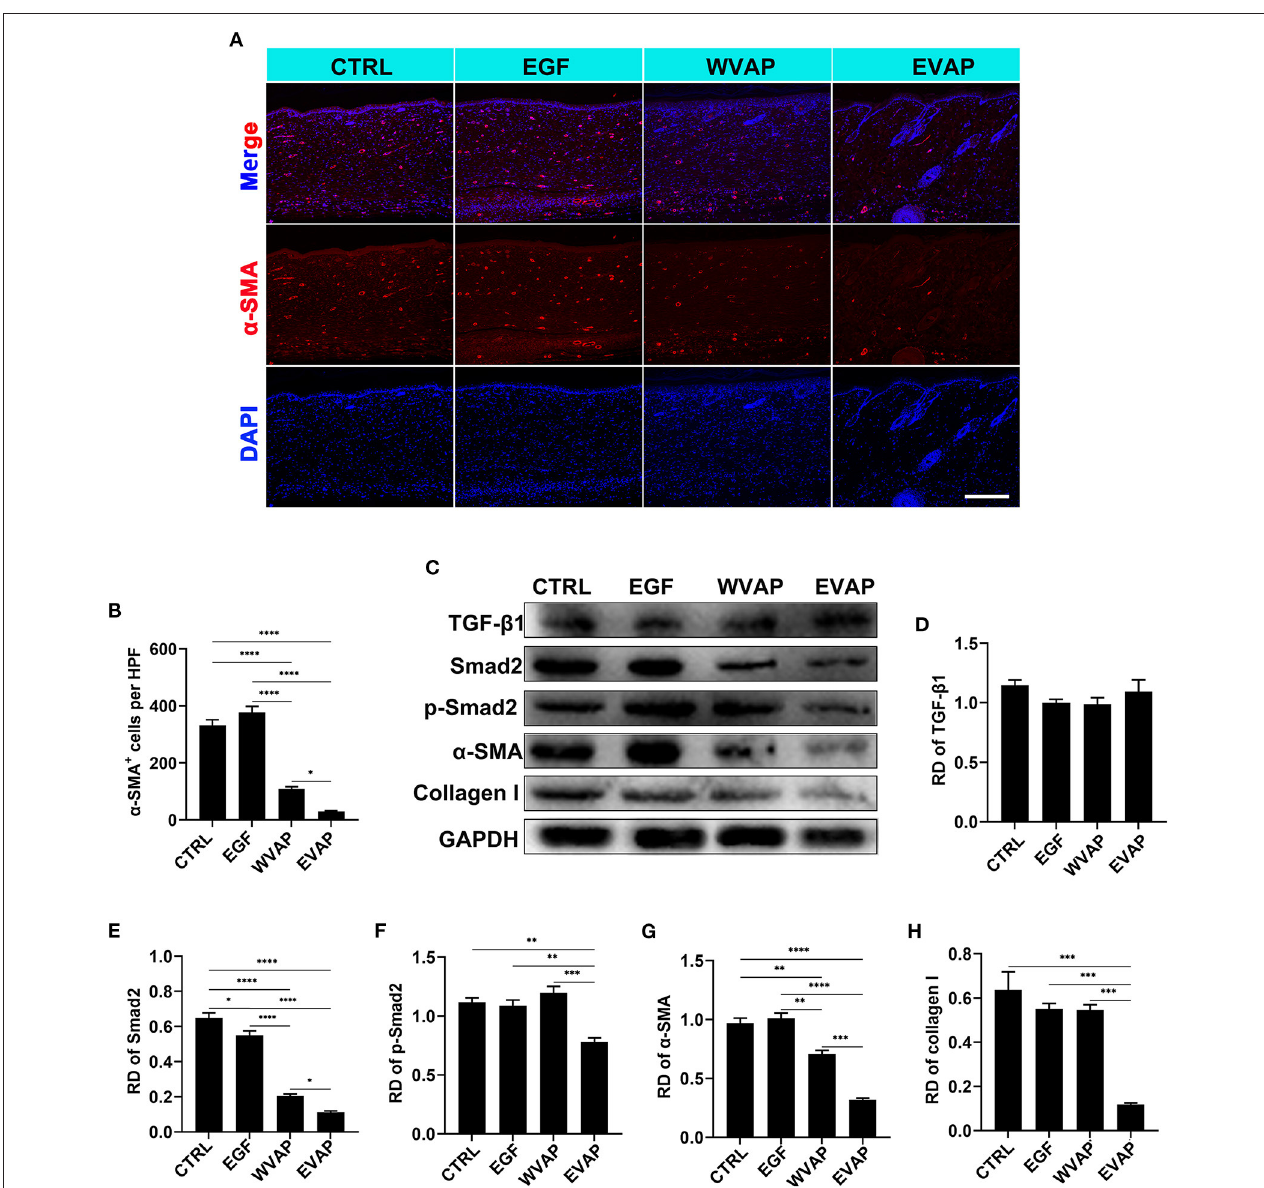
FIGURE 6 | Effects of EVAP on myofibroblast transdifferentiation in the healed tissue of model rat s. (A) α -SMA staining on the histological sections (scale bar = 300 µ m). (B) Quantification of α -SMA + cells per HPF. (C) Protein expressions of TGF- β 1, Smad2, p-Smad2 α -SMA, and collagen I in the healed skin. (D–H) RD of WB bands in (B) . Note that EVAP significantly inhibited the TGF- β signaling pathway in vivo . * P < 0.05; ** P < 0.01; *** P < 0.001; **** P < 0.0001; mean ± SD; n = 3. RD, relative density; α -SMA, α -smooth muscle actin; WB, western blot.